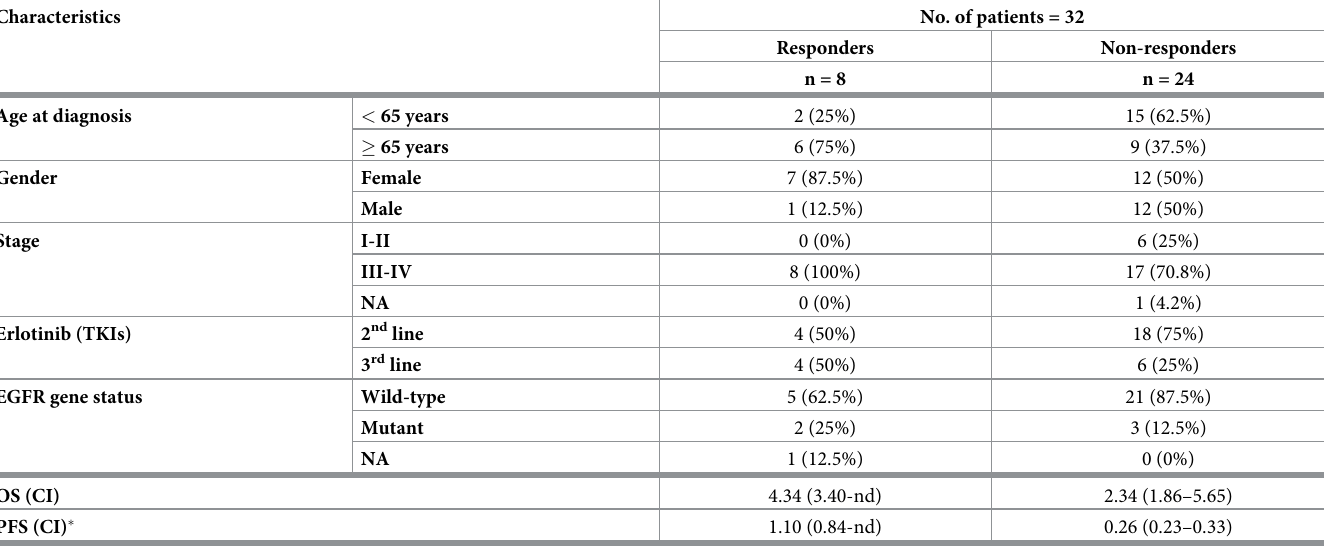
Table 1. Clinicopathological characteristics of NSCLC patients at diagnosis classified as responders and non-responders to erlotinib. Characteristics